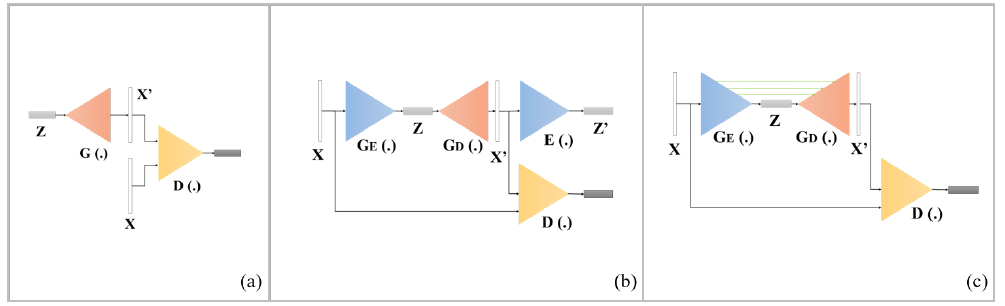
Figure 1. Pipelines of GAN-based anomaly detection networks: ( a ) AnoGAN, ( b ) GANomaly, and ( c )